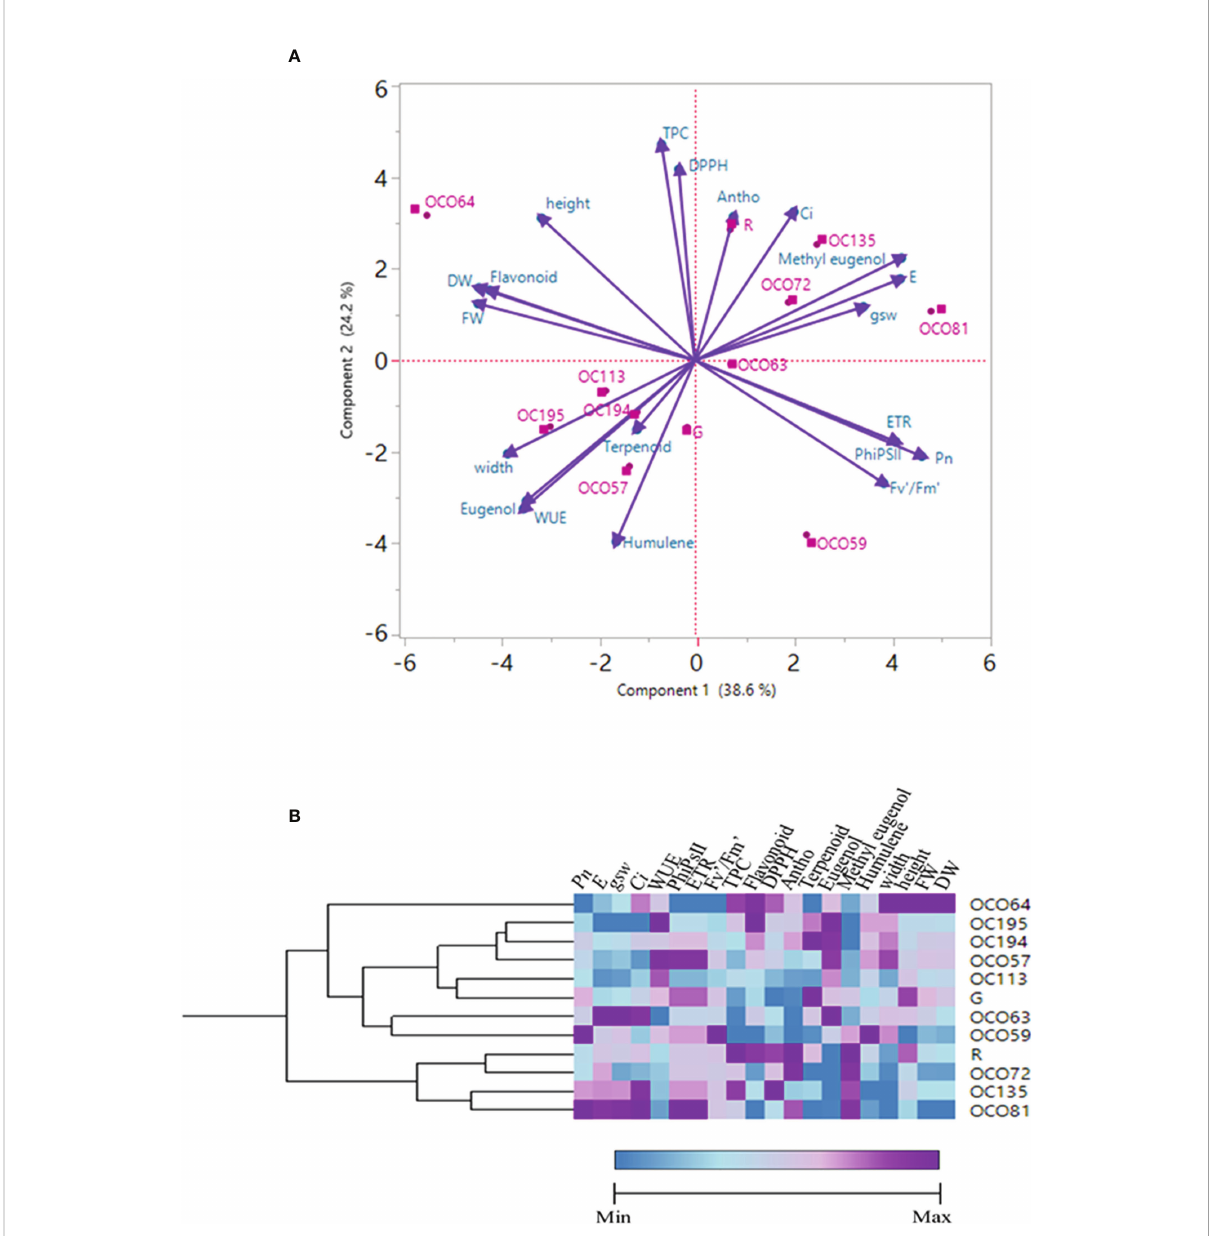
FIGURE 8 Principal component analysis (PCA) displaying the biplot differentiation (A) and Hierarchical clustering analysis of the Euclidean distances (B) between four growth parameters, eight parameters of photosynthetic parameters, fi ve secondary metabolite parameters, and three volatile organic compounds of all cultivars/accessions of Thai holy